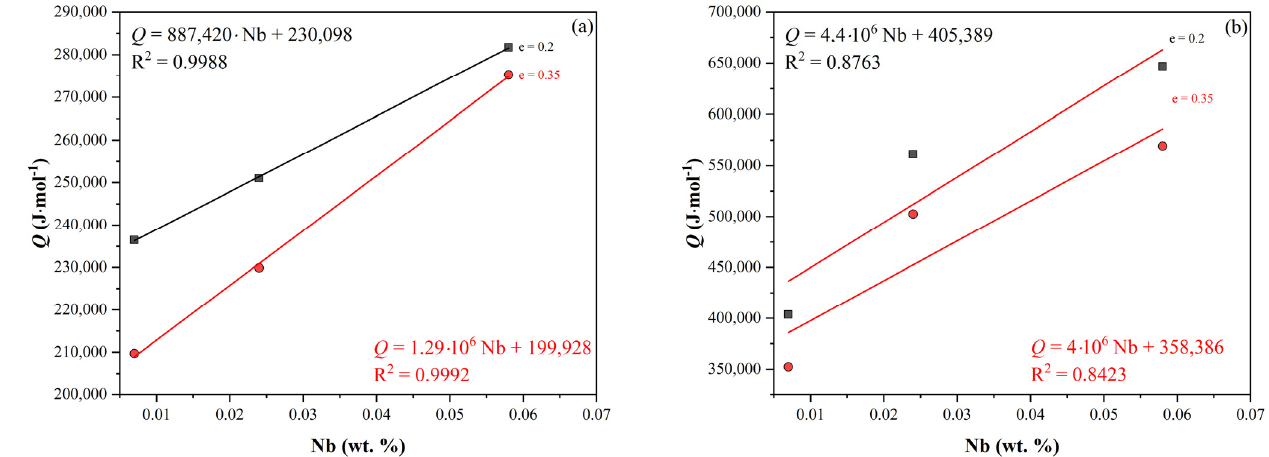
Figure 5. Dependence of Q on the strain and Nb content (without SIP): ( a ) without SIP and ( b ) with SIP.